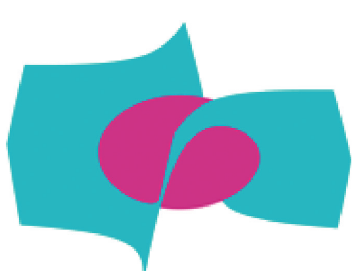
Figure 12: Intersection of both surfaces.